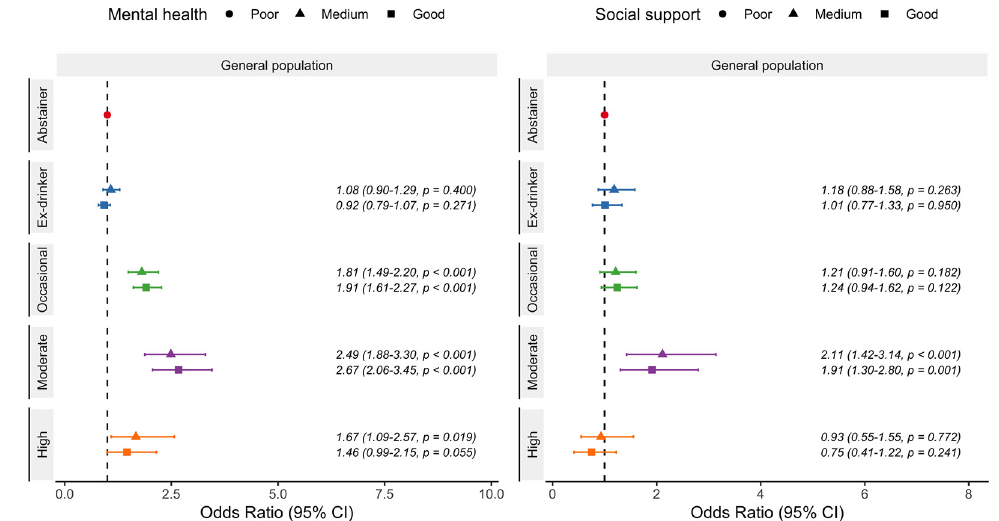
Figure 4. Odds ratio and 95% confidence intervals of reporting medium and good mental health and social support in the Spanish adult population ( ≥ 18 years) according to beer consumption. Drinkers were classified as occasional (a maximum of 3 days per month), moderate (women: up to 12 g of alcohol per day; men: up to 24 g of alcohol per day) or high (women: more than 12 g of alcohol per day; men: more than 24 g of alcohol per day). Analyses adjusted for age, gender, social class, edu- cational level, year of the survey, place of residence, physical activity, diet, tobacco, and body mass index. National Health Survey of Spain 2012, 2017.